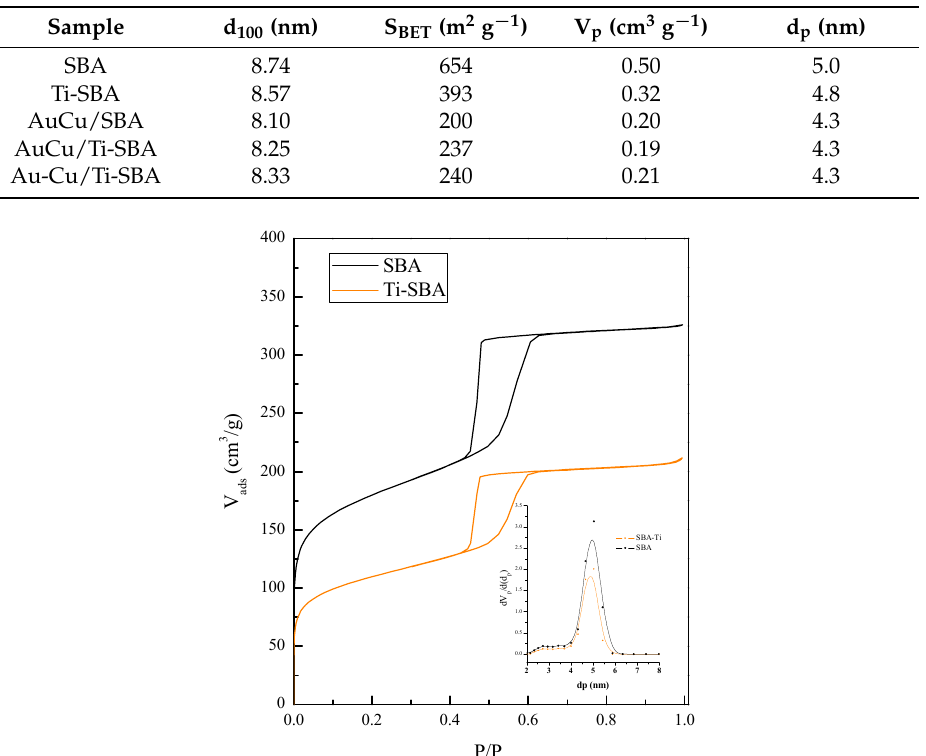
Table 1. Structural and textural properties of the support and as-prepared samples.